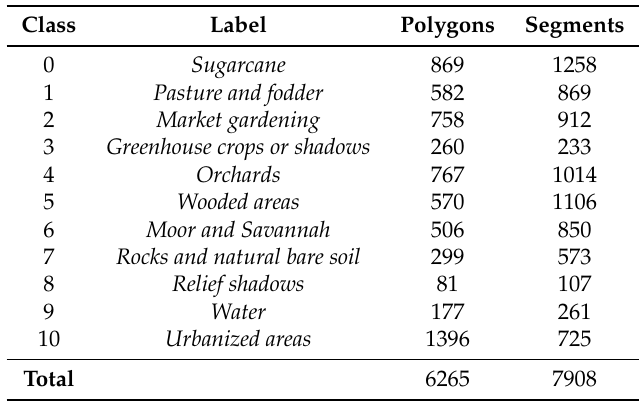
Table 1. Characteristics of the Reunion island ground